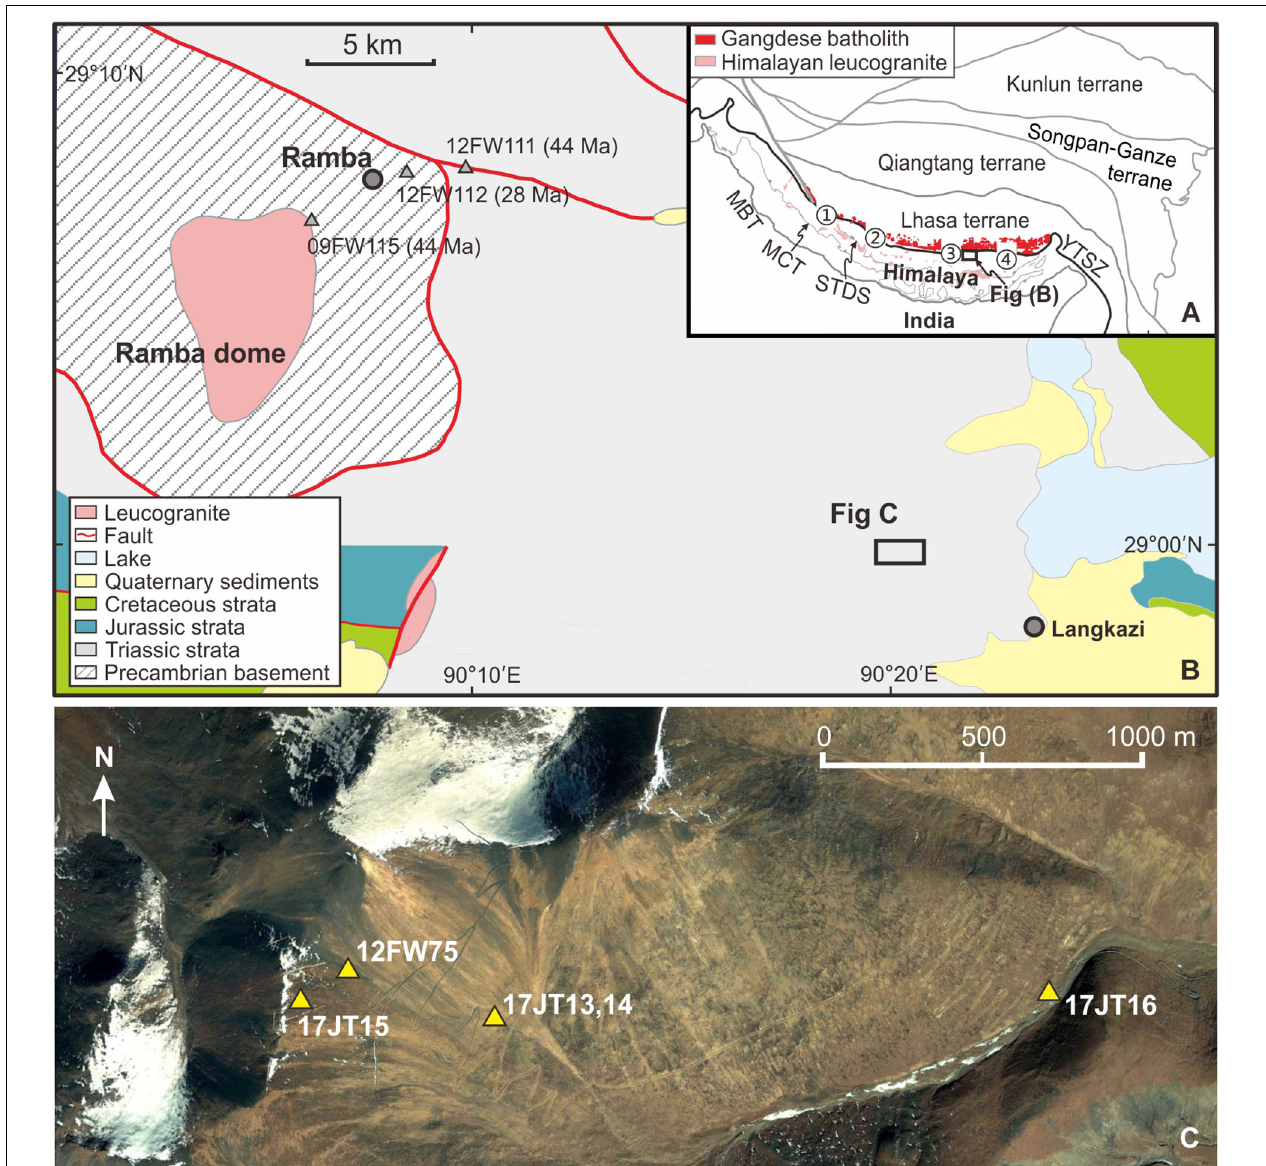
FIGURE 1 | Geological map of the study area and sample location. (A) Geological background of study area and distribution of identified middle Eocene magmatic rocks along the suture zone. (B) Simplified geological map of the study area. (C) Outcrops and distribution of samples (base map from Google Earth). Abbreviations: MBT, Main Boundary Thrust; MCT, Main Central Thrust; STDS, South Tibetan Detachment System; YTSZ, Yarlung Tsang suture zone. Middle Eocene magmatic rocks: (cid:172) Xiao Gurla Range (Pullen et al., 2011); (cid:173) Niuku (Ding et al., 2005); (cid:174) Langshan OIB (Oceanic island basalt)–type gabbro (Ji et al., 2016); (cid:175) Yardoi